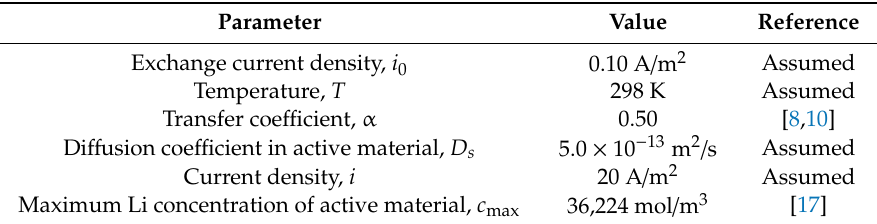
Table 2. The parameters of the simplified physico-chemical